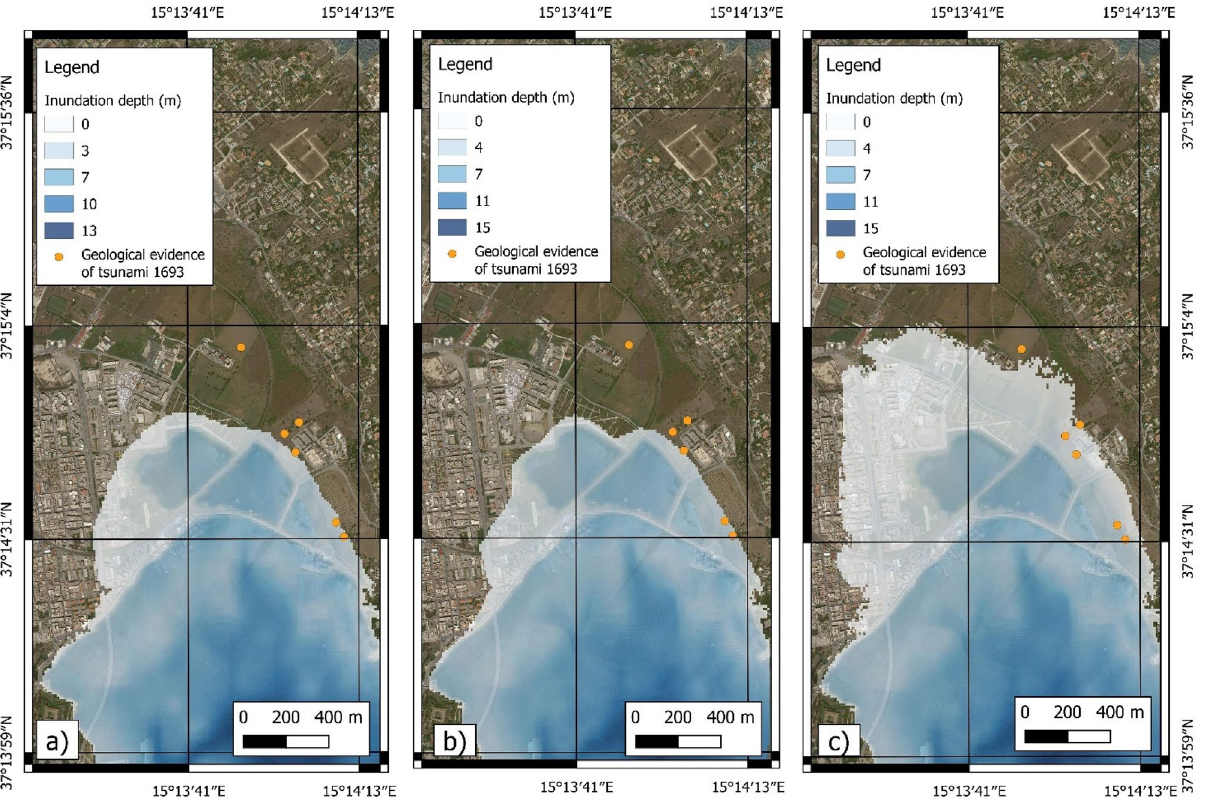
Figure 14. Modelling of tsunami inundation in the Augusta area; ( a ) SFS scenario; ( b ) SLS scenario; ( c ) DTS scenario. The maps were obtained by co-authors through QGIS—software (version 3.14.16); https:// www. qgis.